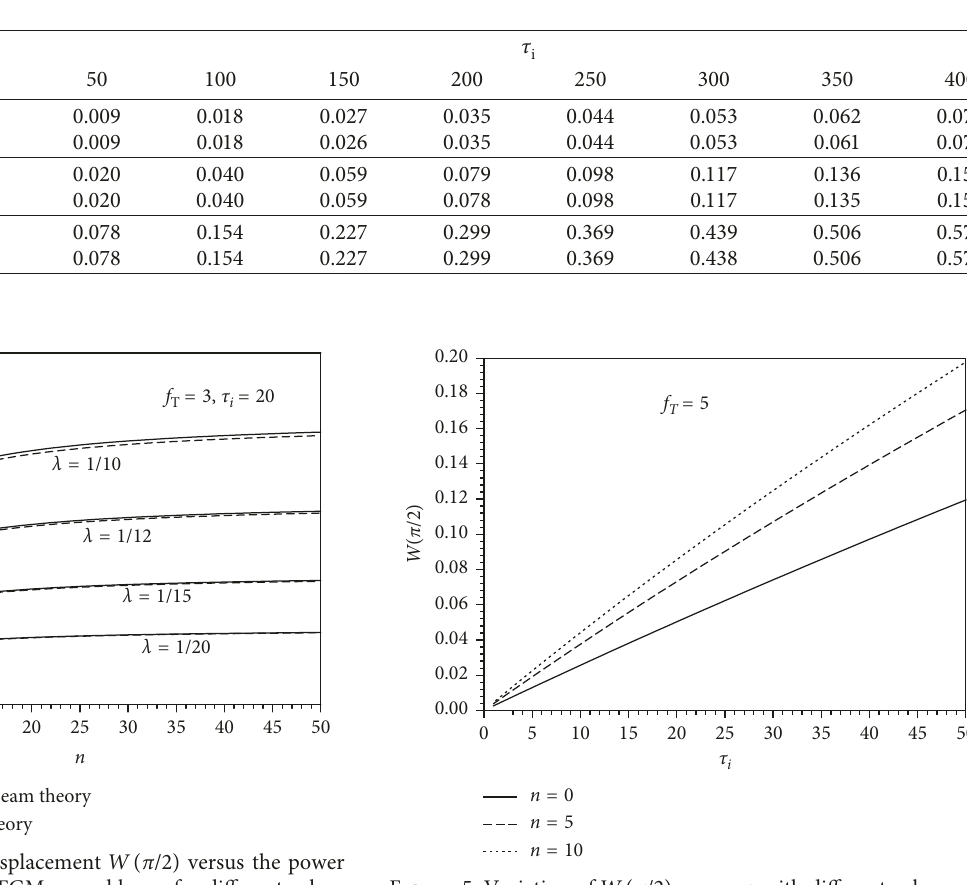
π /2 versus τ i with different values of n ( )